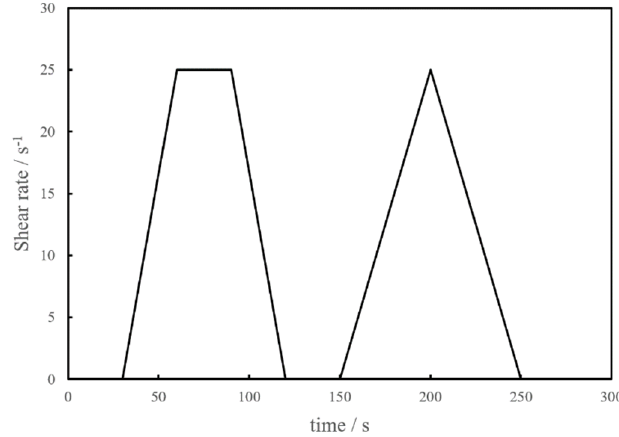
Figure 3. The rheological mechanism.